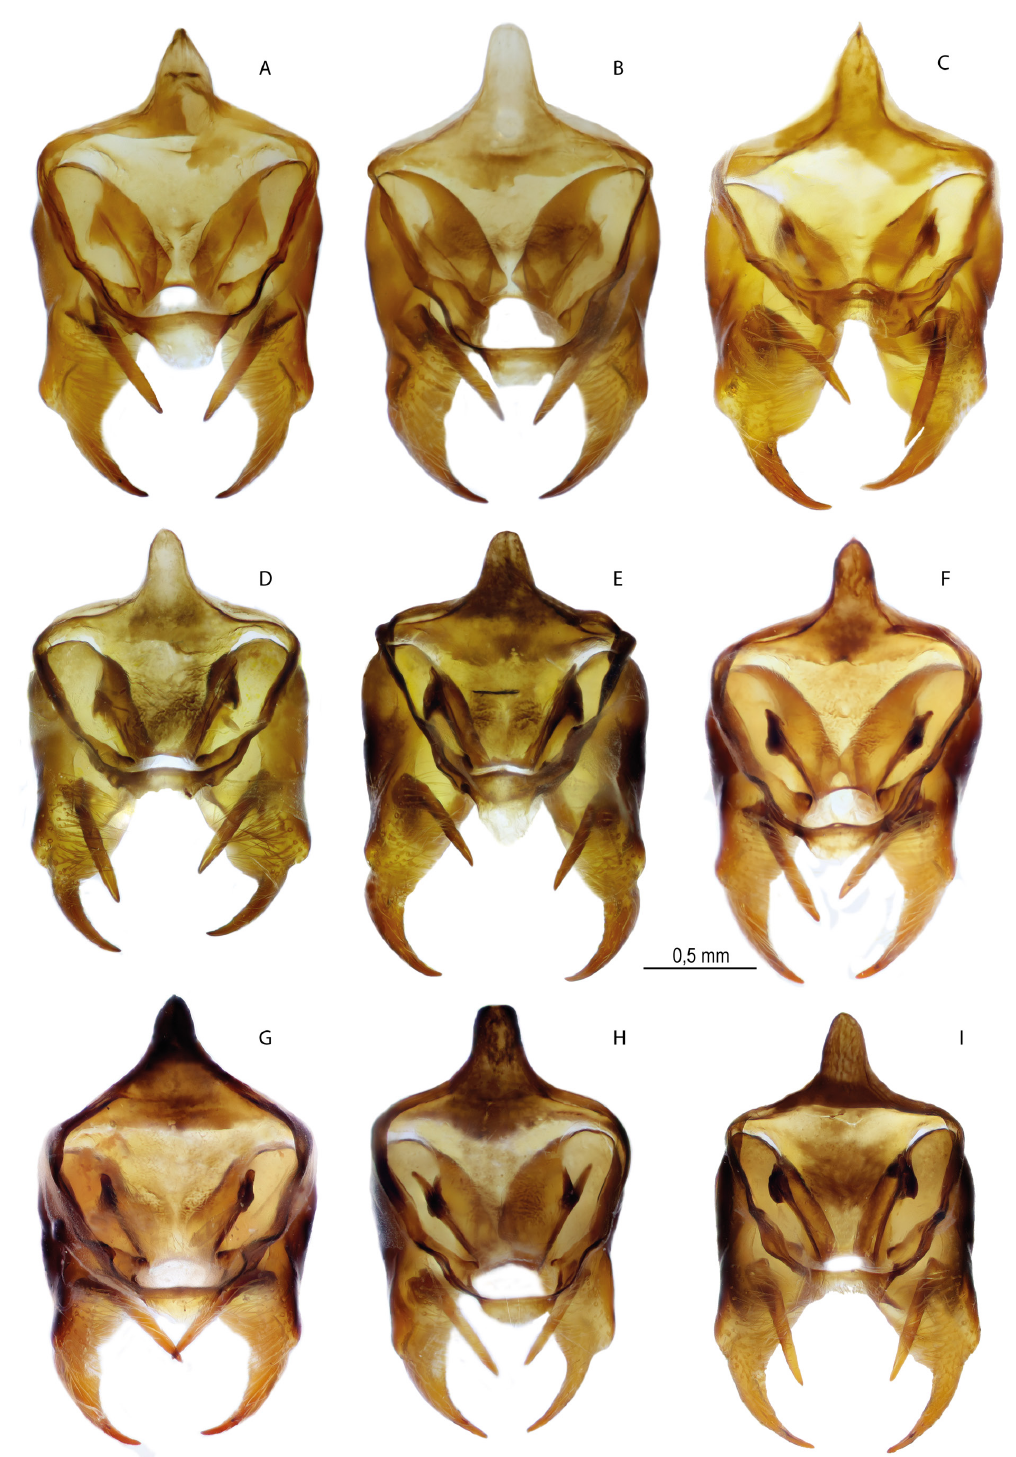
Fig. 17. Male genitalia (without aedeagus) in dorsal projection. A–C . Melitaea timandra